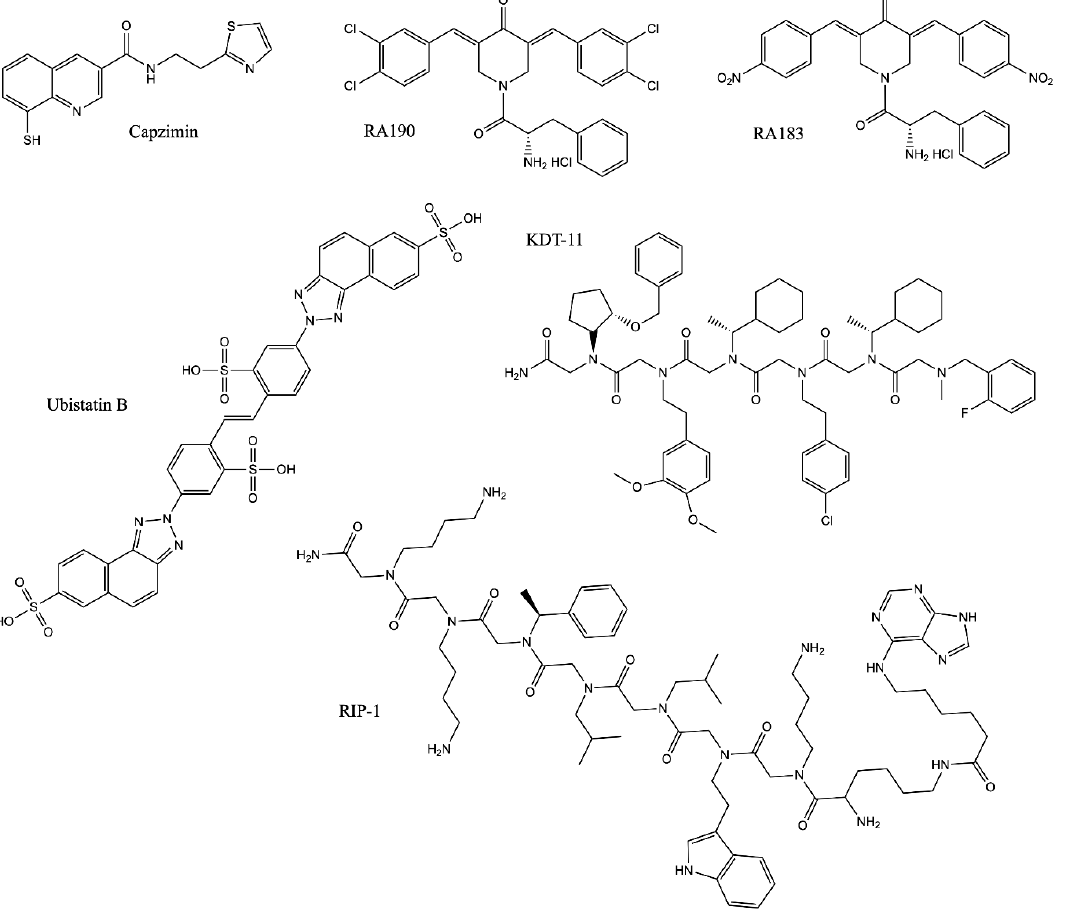
Figure 3. Structures of non-20S UPS inhibitors. For more information, see Table 3.